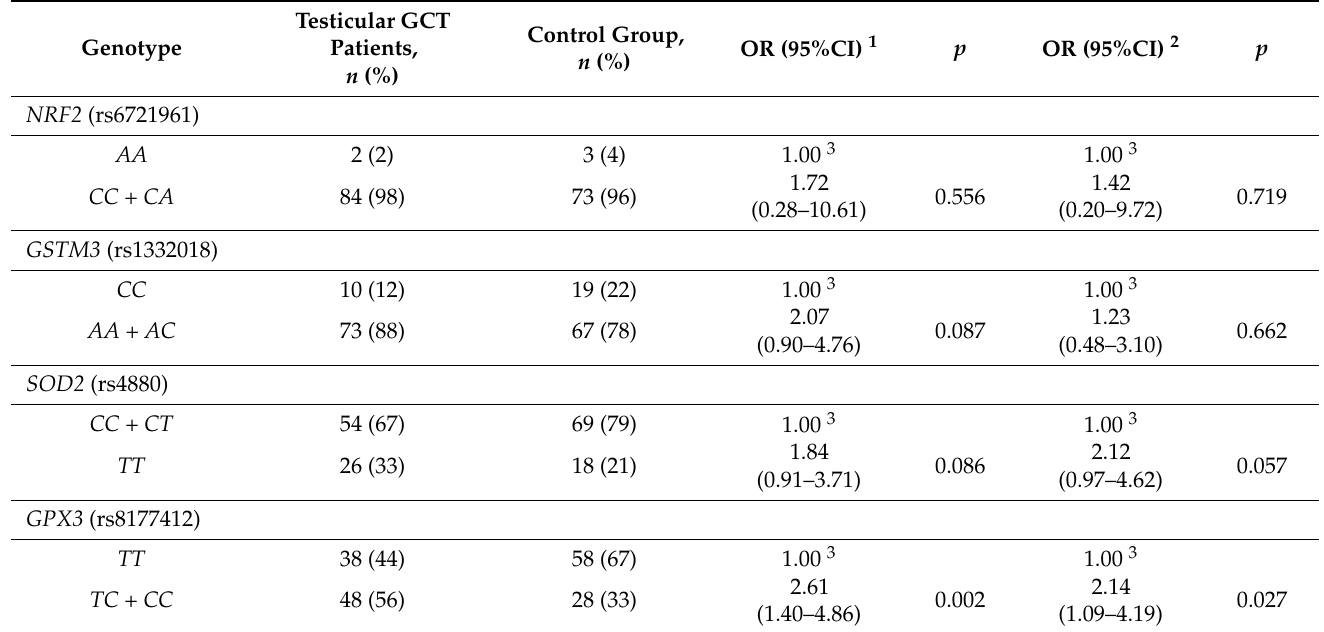
Table 2. The association of NRF2, GSTM3, SOD2 and GPX3 polymorphisms with the risk for testicular GCT development.